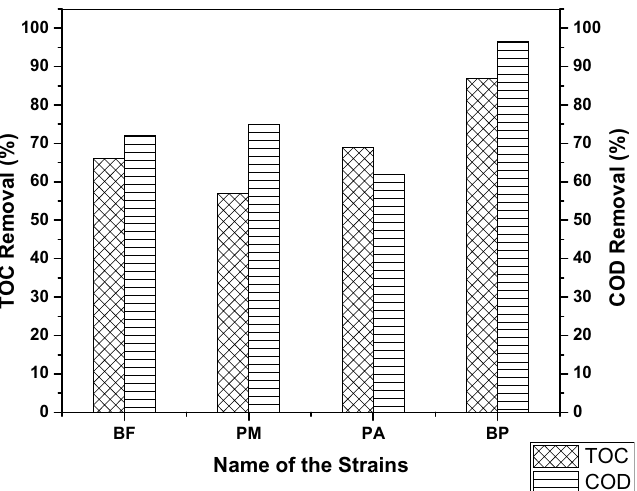
Figure 3. TOC and COD removal percentage of Indanthrene Blue RS by individual strains and consortium-BP after 9 h incubation.